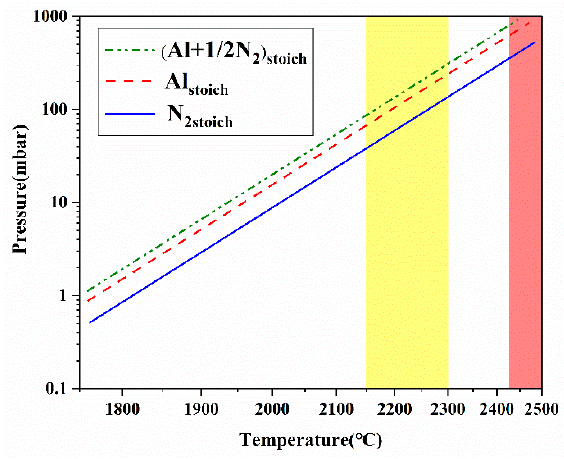
Figure 1. Partial pressure of Al and N 2 versus temperature in the AlN-N 2 system [25]. The yellow colored area highlights the suitable temperature window for growth of bulk AlN crystals. The red colored area reflects the limitation of the AlN decomposition point.